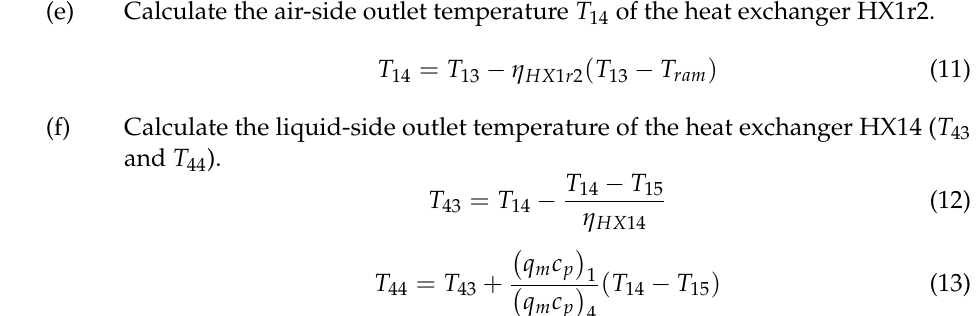
iv. Compare the result with the assumed turbine pressure ratio; return to recalculate if not matched. Calculate the air-side outlet temperature T 14 of the heat exchanger HX1r2.